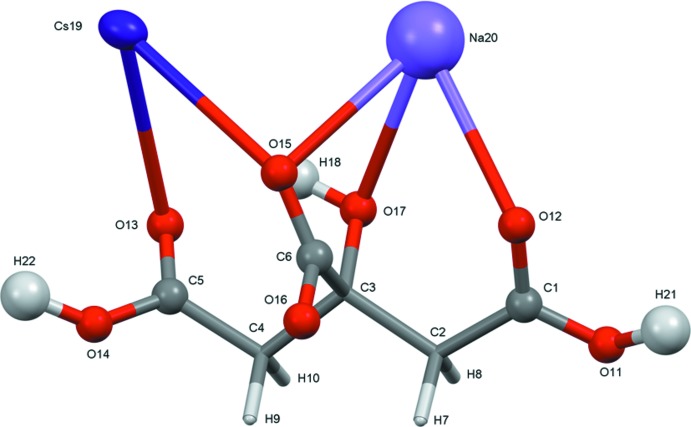
The asymmetric unit of NaCsHC6H5O7, with the atom numbering and 50% probability spheroids.